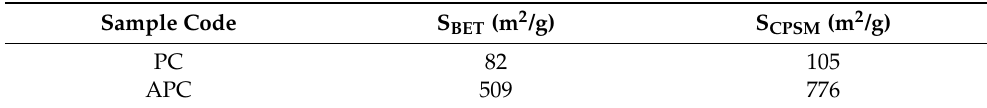
Table 2. Specific surface area (SSA) estimation derived from the classic BET model as well as from the CPSM